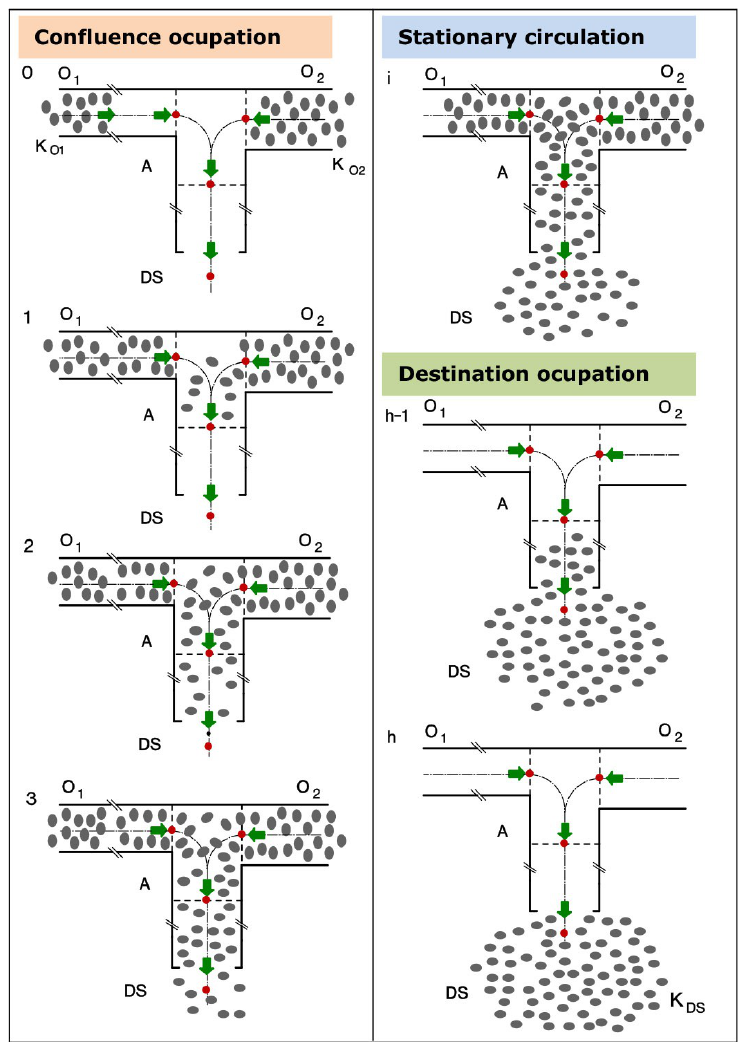
Figure 13. Process in a simple